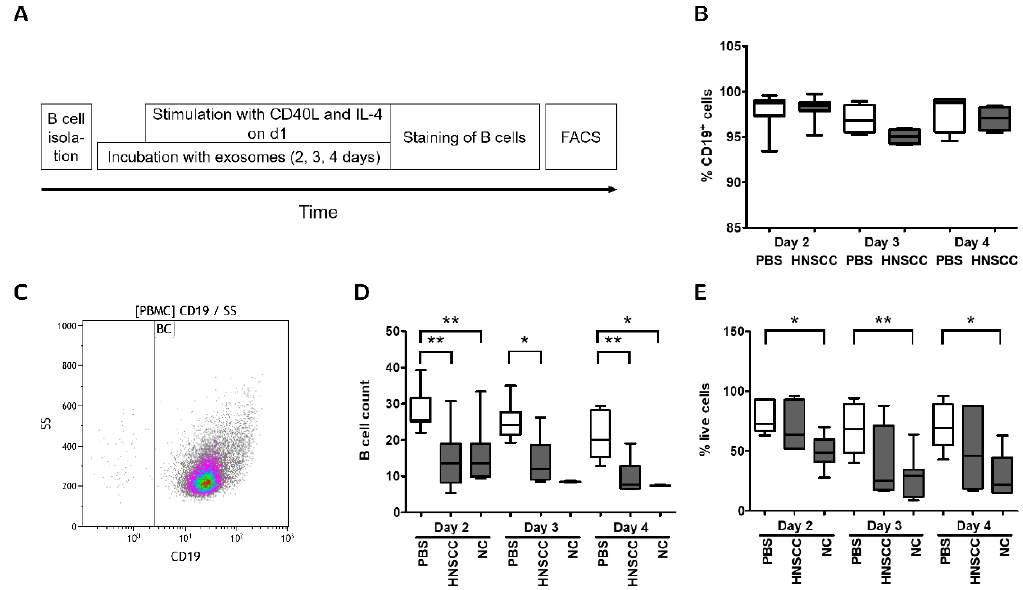
Figure 3. B cells were isolated from citrate blood samples drawn from healthy donors. ( A ) B cells were co-cultured with exosomes for up to 4 days and stimulated with CD40 Ligand (CD40L) and Interleukin 4 (IL-4) on day 1. Each day, B cells were studied by microscopy and counted using trypan-blue stain and an automated cell counter. ( B ) B cell purity as assessed by CD19-positivity of cells was above 90% throughout culture. n = 8 (Day 2), n = 4 (Days 3 & 4). ( C ) Purity of isolated B cells was confirmed by anti-CD19 stain and subsequent FACS analysis. Purity after isolation was always above 98%. ( D ) B cell survival as measured by FACS cell count. B cell counts were reduced after co-culture with both healthy volunteer and HNSCC exosomes. There were no significant di ff erences between HNSCC and NC exosomes. n = 10 (HNSCC exosomes on d2); n = 9 (NC exosomes and PBS on d2); n = 6 (PBS and HNSCC exosomes on d3 & d4); n = 2 (NC exosomes on d3); n = 3 (NC exosomes on d4). ( E ) B cell viability as measured by trypan blue staining and automated counting was significantly lower after co-culture with healthy volunteer exosomes. A similar, but non-significant trend was observed after co-culture with HNSCC exosomes. There were no significant di ff erences between HNSCC and NC exosomes. n ≥ 5 (HNSCC: 5 [d2], 9 [d3], 6 [d4]; NC: 6 [d2], 9 [d3], 5 [d4]; PBS: 5 [d2], 7 [d3], 6 [d4]). **: p < 0.01; *: p < 0.05. HNSCC, exosomes from blood plasma of HNSCC patients. NC = no cancer, exosomes from blood plasma of healthy volunteers.